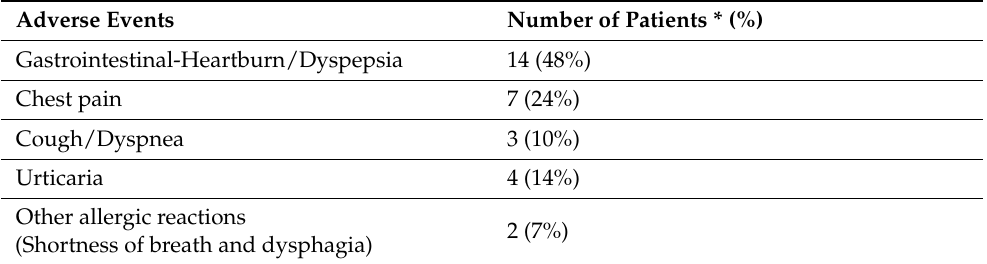
Table 2. Adverse events associated with